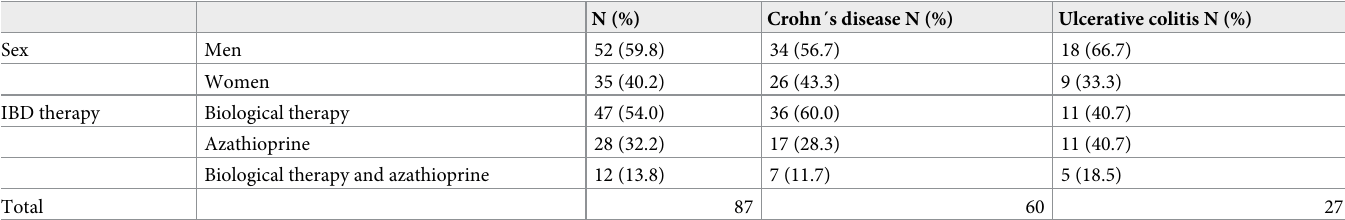
Table 1. Basic demographics and disposition of